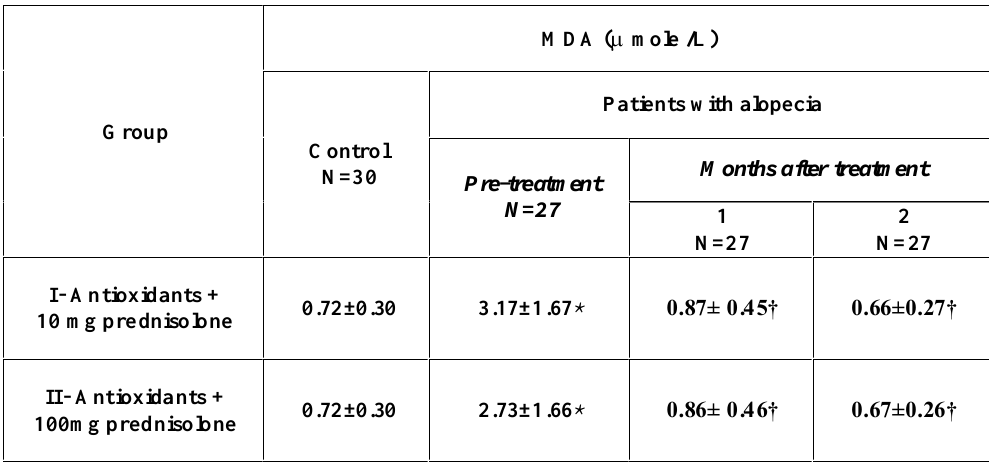
Table (1): Effect of the addition of nutrient antioxidants (A, E, &C) to prednisolone therapy (10& 100 mg) on plasma MDA levels in patients with alopecia areata.